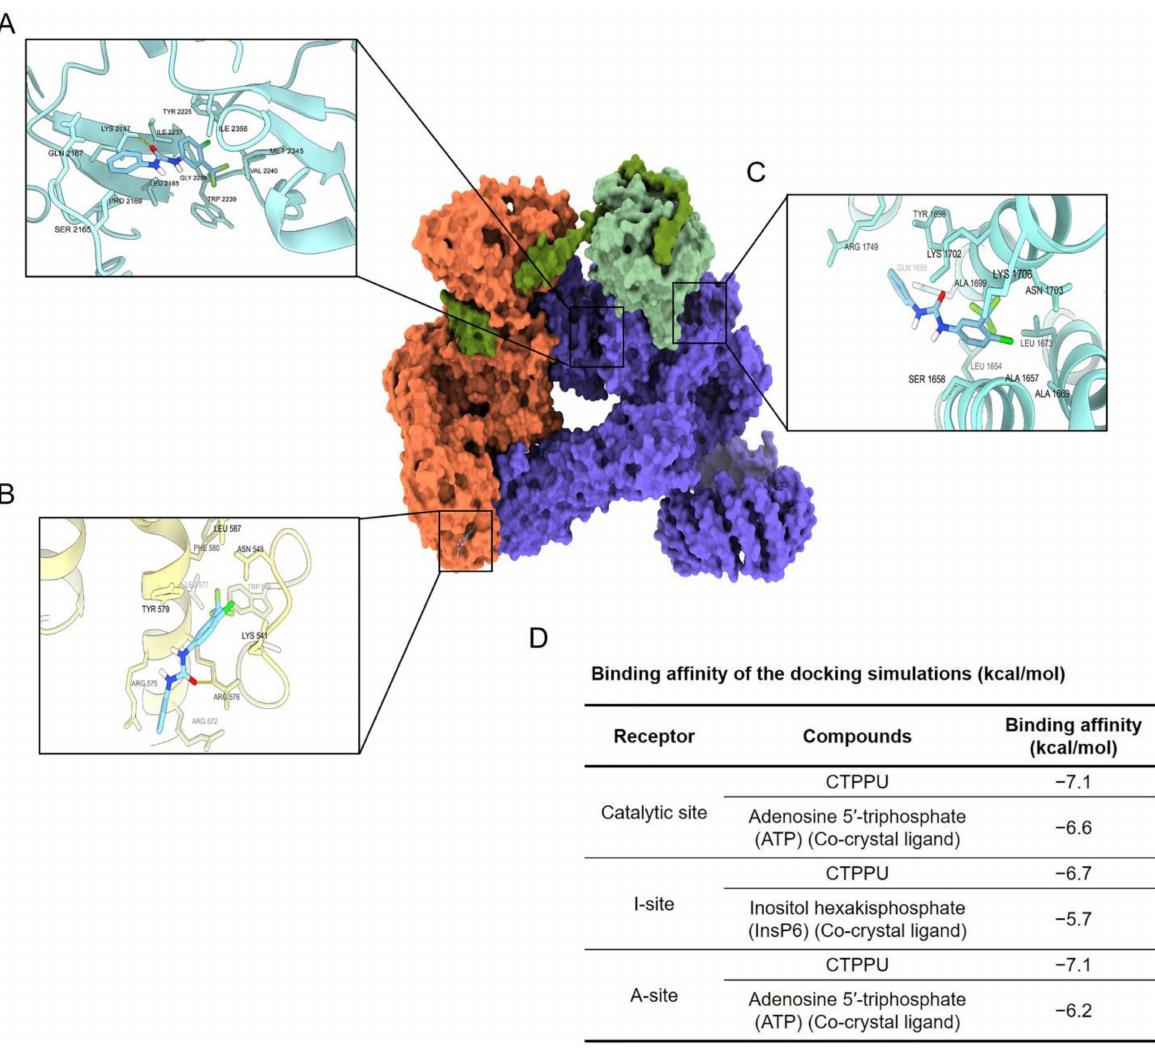
Figure 8. Binding interaction of CTPPU in complex with mTORC2. Docking interaction profile of CTPPU in complex with mTORC2: ( A ) the catalytic site of mTORC2, ( B ) the A-site, ( C ) the I-site. ( D ) The binding affinities of CTPPU against the